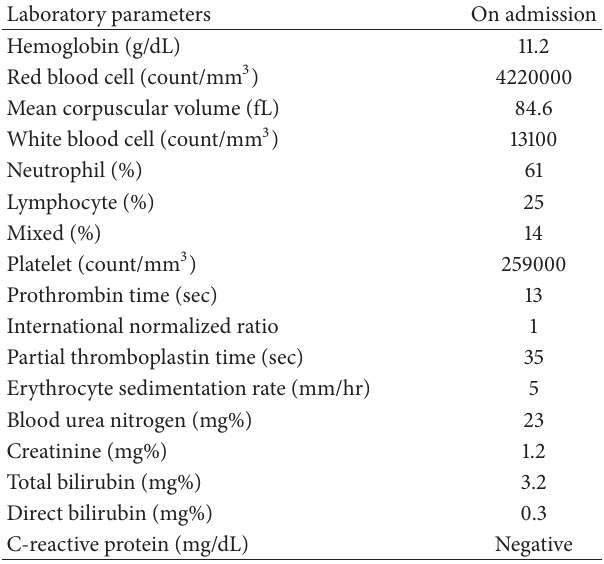
Table 1: Viral studies and serum immunoglobulin level on admis- sion time.